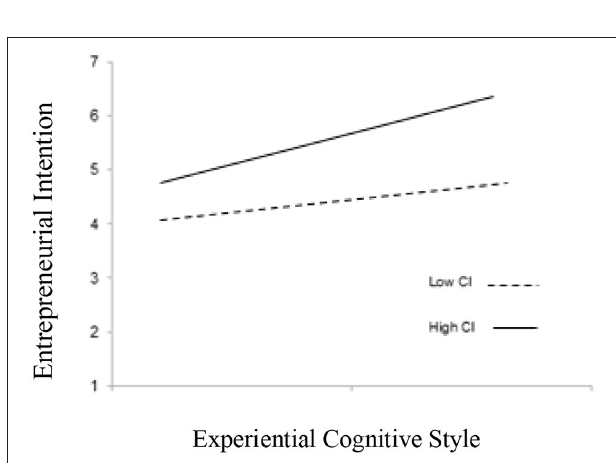
FIGURE 3 | Interaction effects of experiential cognitive style and informal learning on entrepreneurial